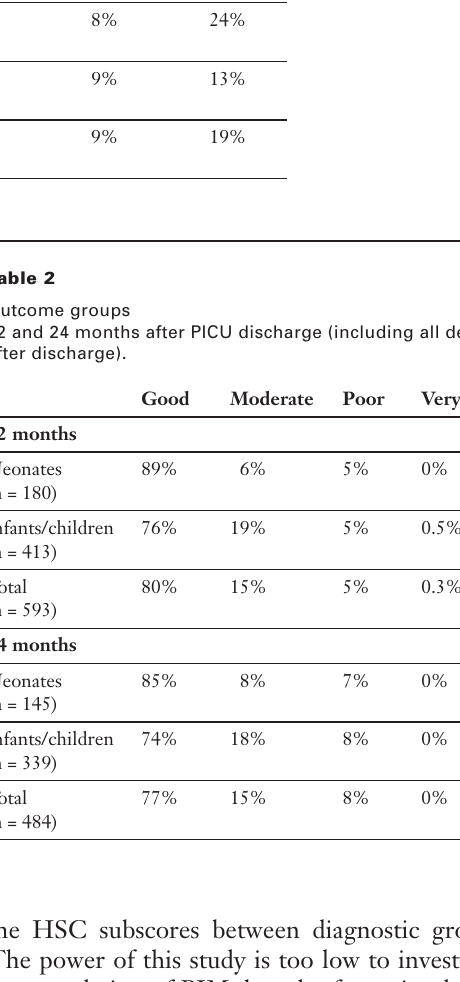
Reason for PICU admission (diagnos- tic groups).